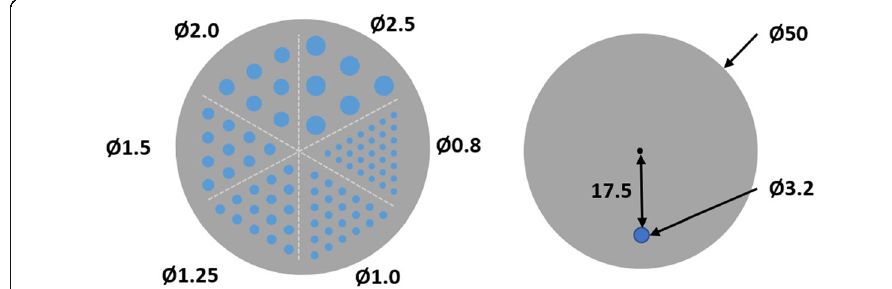
Fig. 2 Phantom cross-sections with dimensions in mm. Left: cross-section of the Derenzo phantom with the fillable rod diameters. Right: NEC phantom